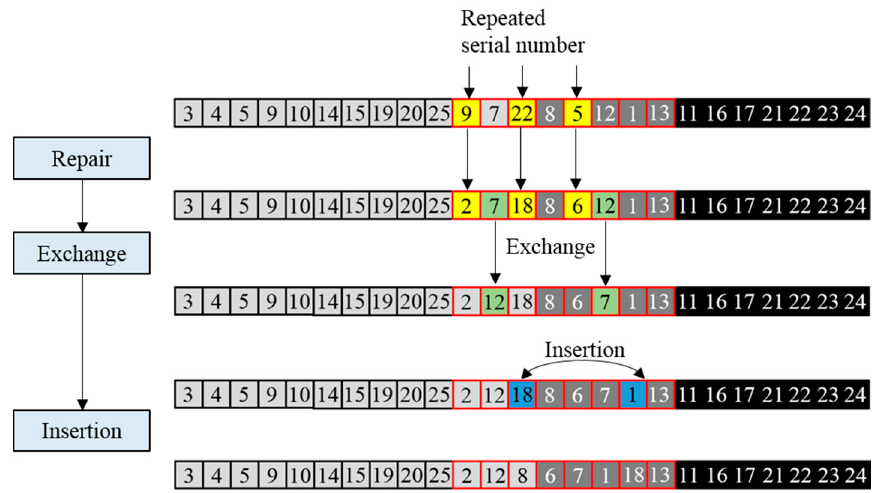
Figure 9. Specific illustration of the intelligent operations of repair, exchange, and insertion.